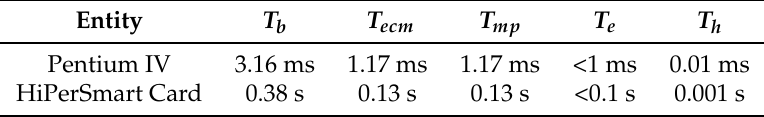
Table 5. Various cryptographic operations based on execution time [21,34].